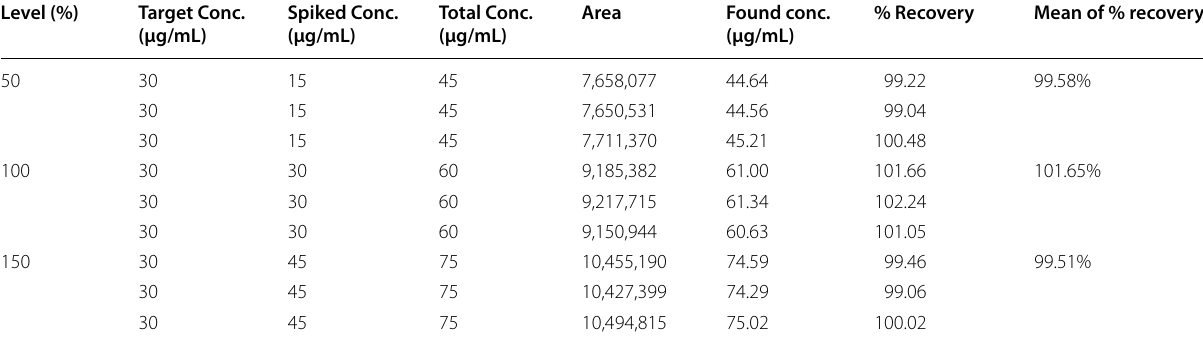
Table 3 Accuracy data for FIK